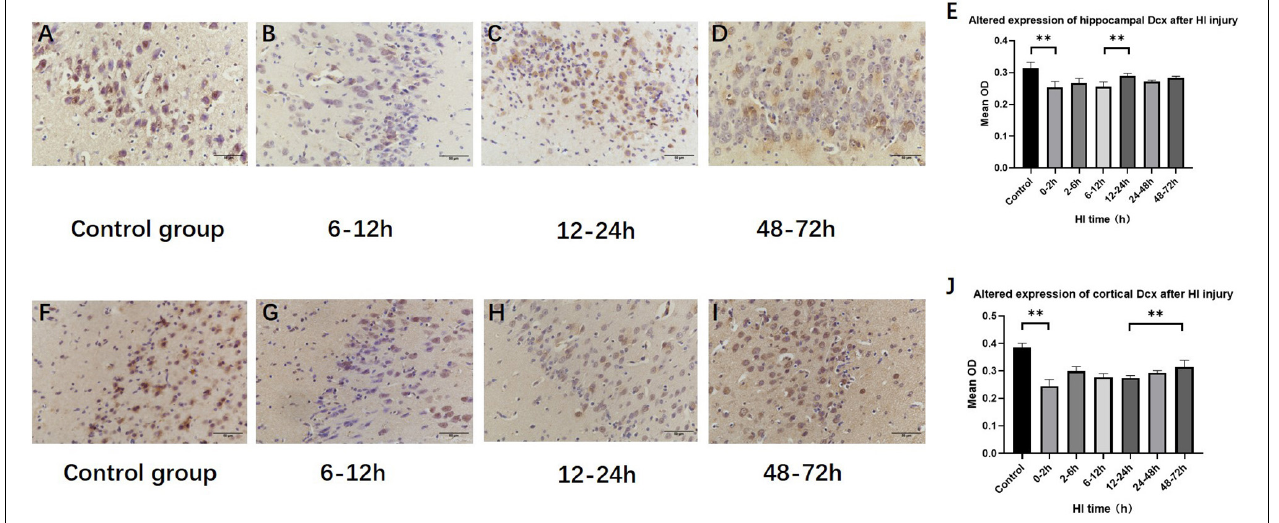
FIGURE 6 | Changes in DCX expression in the hippocampus and cortex after HI ( × 400). (A) DCX immunohistochemical staining of the hippocampus in the control group. (B–D) DCX immunohistochemical staining of the hippocampus in HI groups at 6–12, 12–24, and 48–72 h after HI. (E) The expression of DCX in the hippocampus decreases at 0–2 h and significantly increases at 12–24 h after HI injury. (F) DCX immunohistochemical staining of the cortex in the control group. (G–I) DCX immunohistochemical staining of the cortex in groups at 6–12, 12–24, and 48–72 h after HI. (J) Compared with the control group, DCX expression significant decrease in the cortex at 0–2 h after HI injury, and the expression of DCX at 48–72 h after HI is significantly increased. ∗∗ P < 0.01; data are expressed as mean ± SD.